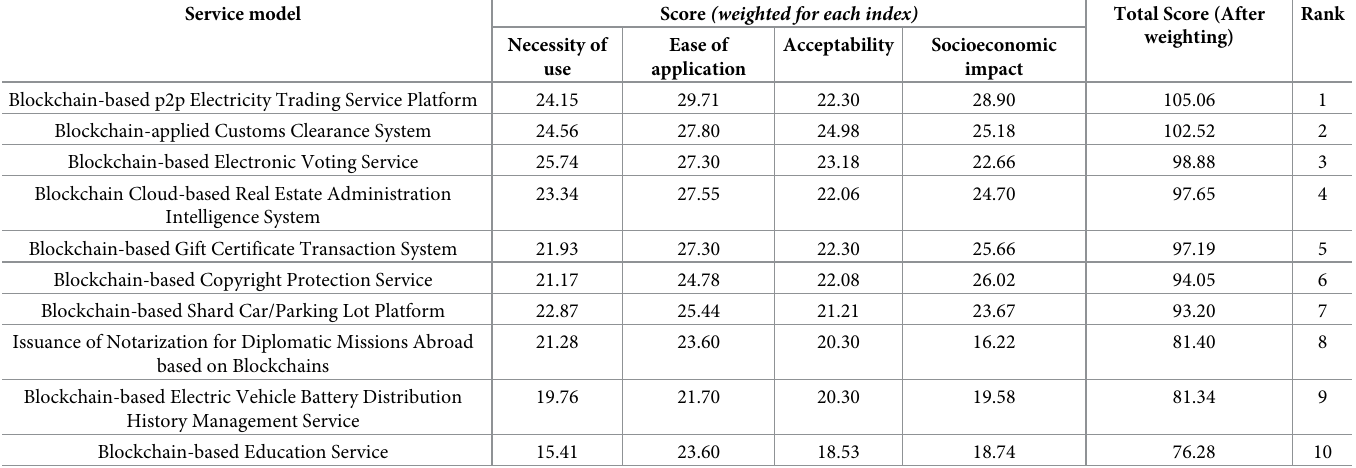
Table 7. Delphi results of utility evaluation for blockchain application services. Service